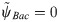
Steady-state sensitivity analysis for antibiotic concentration.The number of bound bacteria, BB, is a monotone decreasing function of the antibiotic concentration, A, in all cases, as are the number of free bacteria, BF, and the total number of bacteria, BT, in Case A. In Cases B–D the free and total bacterial burdens increase initially, before decreasing with increasing antibiotic concentration. (Note that, except near A = 0 μg ml−1, all bacteria are resistant at steady-state in the presence of antibiotic, see Steady-state analysis). Steady-state solutions to Eqs 1–10 were calculated using fsolve, neglecting the Heaviside step functions which prevent the logistic growth of bacteria when their population size goes beneath one. Parameter values: ψ˜Bac=0 hr−1, ψ˜I=0 hr−1, λ = 0 cm3cell−1hr−1, ρ = 0 hr−1, ω = 1 and IFinit=0 inhib. cm−3. See Tables 2–4 for the remaining parameter values.